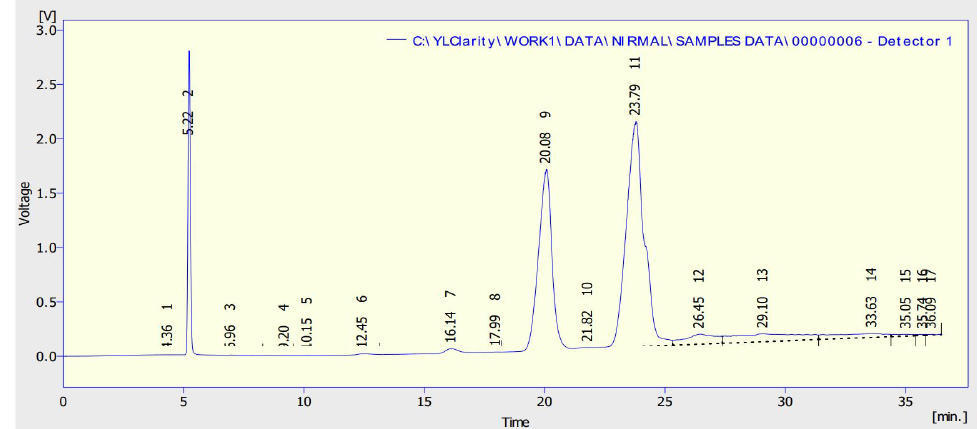
Figure 1. Results from GC-FID instrument with palm biodiesel sample. Dotted line shows overall trend. Table 2. Compounds identified in palm biodiesel sample using GC-FID.